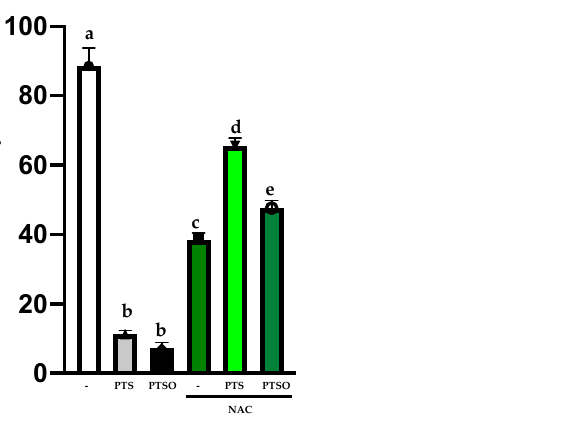
Figure 4. Analysis of apoptosis in MCF-7 ( A ) and T-84 ( B ) cell viability with and without PTS or PTSO for 48 h, revealed with annexin V-FITC/PI staining by cytometry. The graphics show the per- centages of early apoptotic, late apoptotic, and necrotic cells after induction with PTS and PTSO at a concentration of IC50 in MCF-7 cells. ( C ) Histograms of MCF-7 and T-84 cells. Control = untreated control cells . The experiment was repeated independently three times yielding similar results. **** = p < 0.0001; *** = p < 0.001.